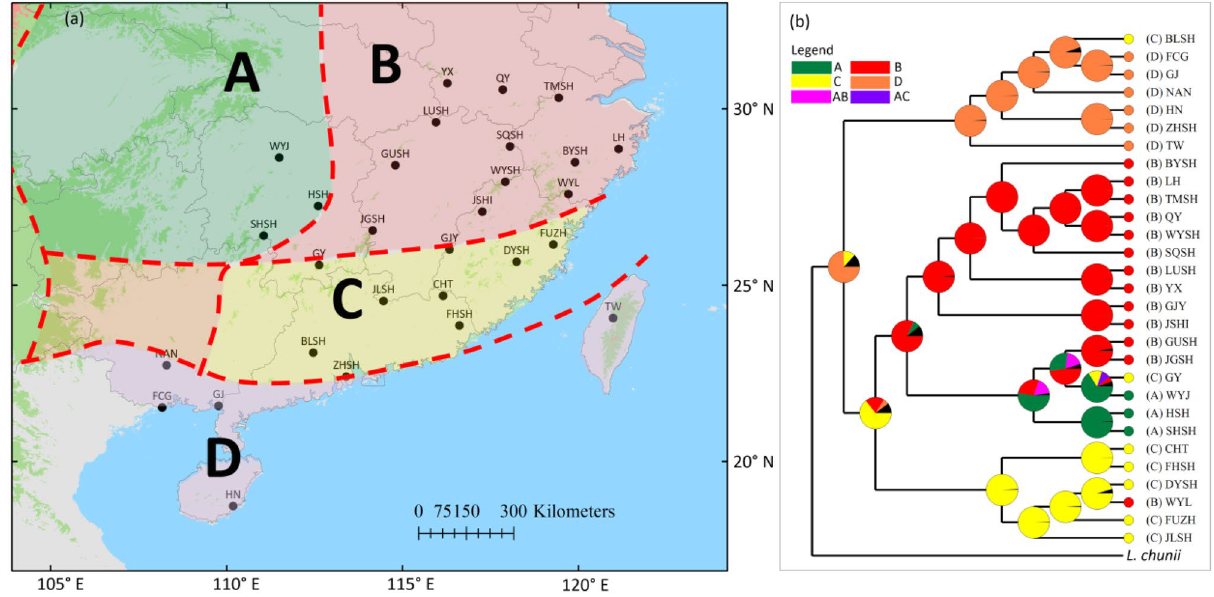
Figure 3. ( a ) The four major floristic divisions (A–D) in southeast China according to Wu et al., 2 (ArcGis 10.2, ESRI, www.esri.com), and ( b ) ancestral area reconstructions based on the Bayesian binary Markov chain Monte Carlo (BBM) method implemented in RASP using the BEAST-derived phylogeny of 29 Lindera aggregata populations (see Fig. 1b). Pie charts of each node illustrate the marginal probabilities for each alternative ancestral area derived from BBM, black colour indicate unknown ancestral area.